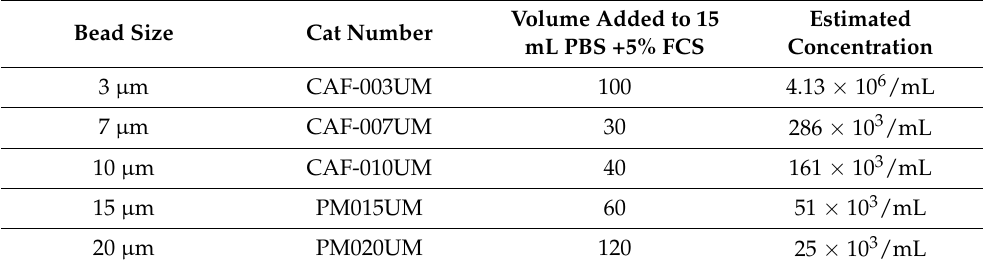
Table 1. Bead mixture used to validate the method consisted of beads selected from 3 µ m to 20 µ m that could be accurately resolved from each other using standard fluorescent flow cytometry. Full details to recreate the samples used in the development of this method are provided. Volume Added to 15 Estimated Cat Number mL PBS +5% FCS Concentration 3 µ m CAF-003UM 100 286 × 10 3